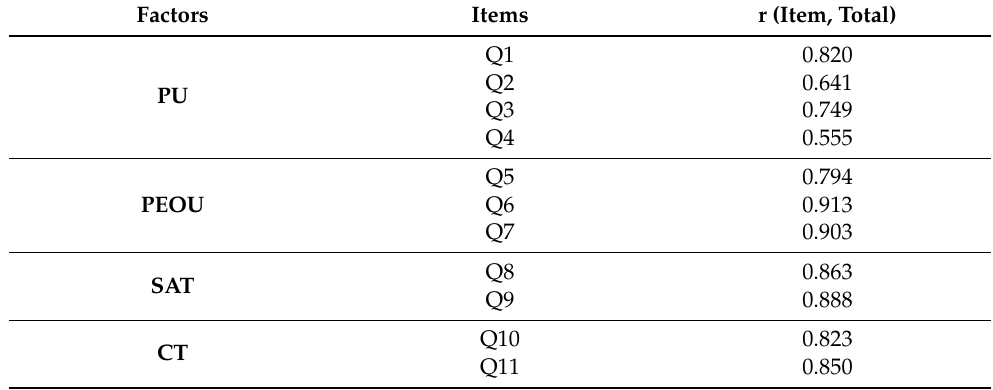
Table 3. Validity of the